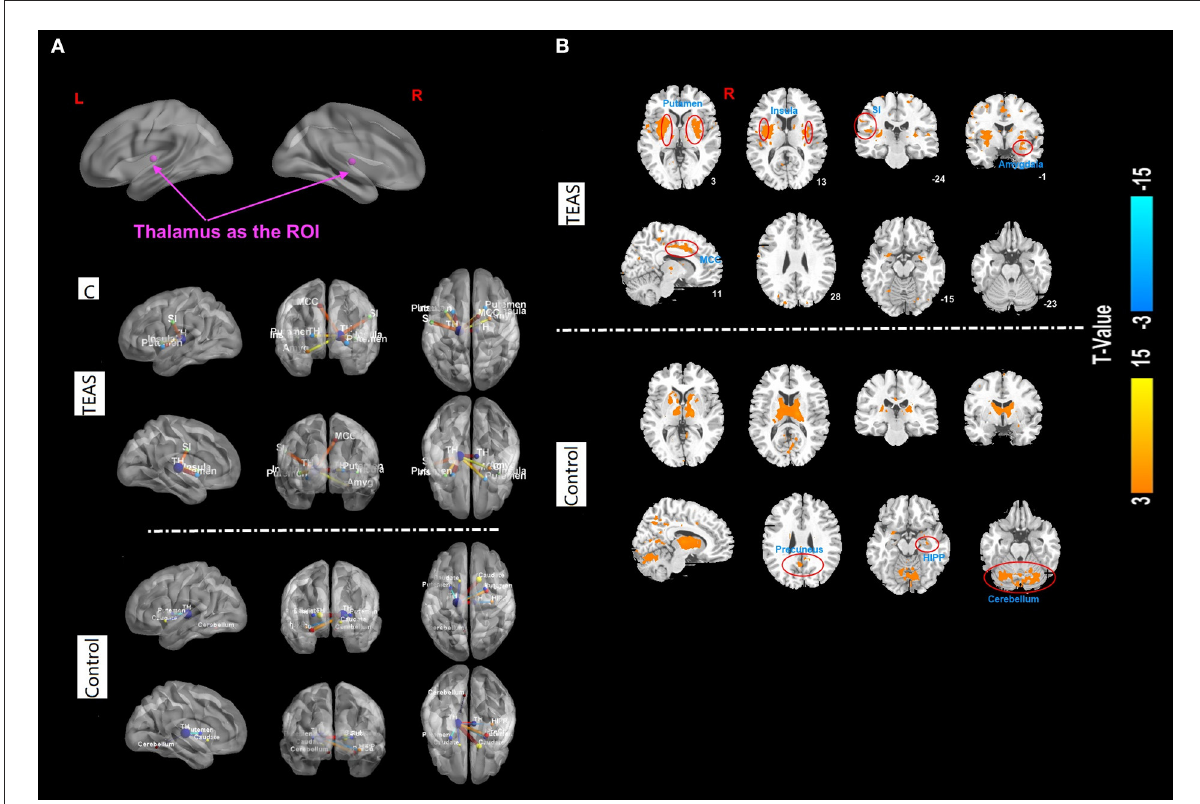
FIGURE5 (A–C) Functional correlation map associated with the ROI in the two groups after TEAS stimulation or control intervention. The warm color shows the positive functional connectivity between the ROI (thalamus) and other regions. The cold color shows negative functional connectivity between the ROI and other regions. Significant positive connectivity was found between the thalamus and bilateral insula, bilateral putamen, left primary SI, right MCC, and right amygdala in the TEAS group. Meanwhile, significant connectivity was detected between the thalamus and the bilateral precuneus, right hippocampus, and bilateral cerebellum in the control group, indicated by orange circles. ROI, region of interest; TEAS, transcutaneous electrical acupoint stimulation; SI, somatosensory cortex; MCC, middle cingulate